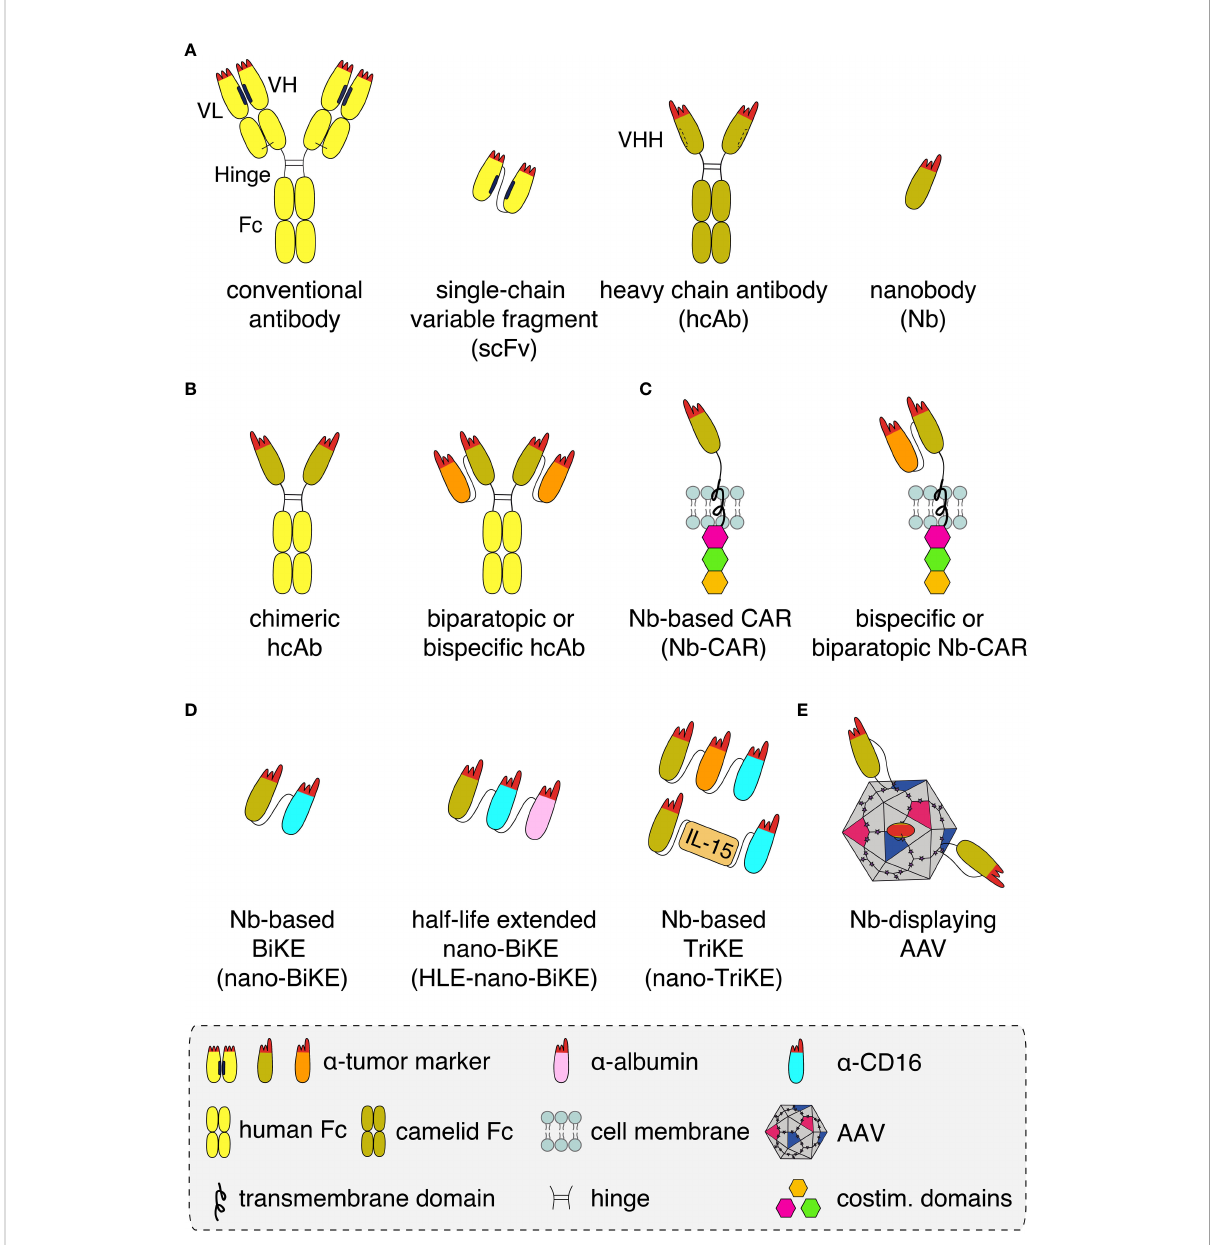
FIGURE 1 Schematics of nanobody-based biologics (A) Conventional antibodies (yellow) contain light and heavy chains that pair via hydrophobic regions (black bars) in the framework of the VL and VH domains and by a disulphide bond (light black line) between the CL and CH1 domains. The complementarity-determining regions (red) of VH and VL together form the antigen-binding paratope. A recombinant antigen-binding module, i.e. a single chain variable fragment (scFv), can be derived from a conventional antibody by genetically fusing the VH and VL domains via a peptide linker. Heavy chain antibodies (hcAb, olive) derived from llamas lack the light chain and the CH1 domain. A hydrophilic patch (dashed bar) of the VHH domain in place of the corresponding hydrophobic region of a VH domain accounts for the excellent solubility of recombinant VHH domains, i.e. nanobodies (Nb), that allows easy fusion to other proteins and/or Nbs. (B) Nanobodies can be converted into hcAbs of any isotype by genetic fusion to hinge, CH2 and CH3 domains, e.g. of human IgG1. Genetic fusion to a second nanobody that recognizes either a second epitope on the same target antigen or a distinct target (orange), results in a biparatopic or a bispeci fi c hcAb, respectively. (C) Genetic fusion of one or two nanobodies to a transmembrane domain and to cytosolic costimulatory domains yields a monomeric, biparatopic or bispeci fi c chimeric antigen receptor (CAR) that can be transduced into T cells or NK cells. (D) Fusion of one or two tumor marker-speci fi c nanobodies to a nanobody recognizing the Fc-receptor of NK cells (CD16, light blue) yields bispeci fi c or trispeci fi c killer cell engagers (nano-BiKEs or nano-TriKEs). As an alternative to a second tumor-speci fi c nanobody, IL-15 can be fused to a tumor marker-speci fi c nanobody and a CD16-speci fi c nanobody to generate a nano-TriKE. Half-life extension (HLE) of these molecules can be achieved by genetic fusion to an albumin-speci fi c nanobody (magenta). (E) Genetic fusion of a membrane protein-speci fi c nanobody into an exposed surface loop of the VP1 capsid protein yields a targeted nanobody- displaying adeno-associated viral vector (AAV) that speci fi cally transduces cells expressing the target